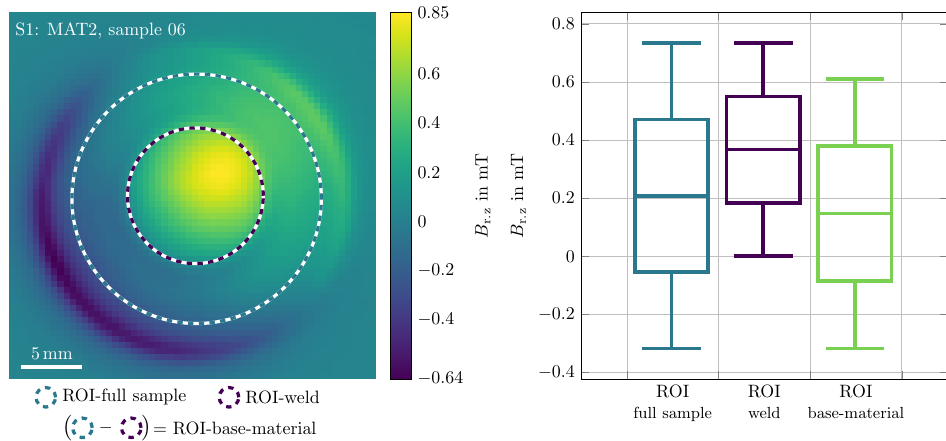
Figure 13. Representation of the ROIs as circular shapes on the example of sample 06 of MAT2 ( left ) with the comparison of the flux density distribution of the individual ROI as boxplots both ROIs and the difference of them as ROI-base-material ( right